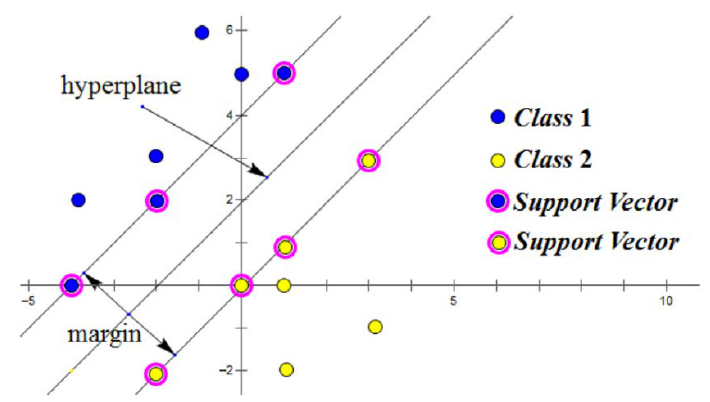
Figure 6. Hyperplan to separate samples from two classes [113].